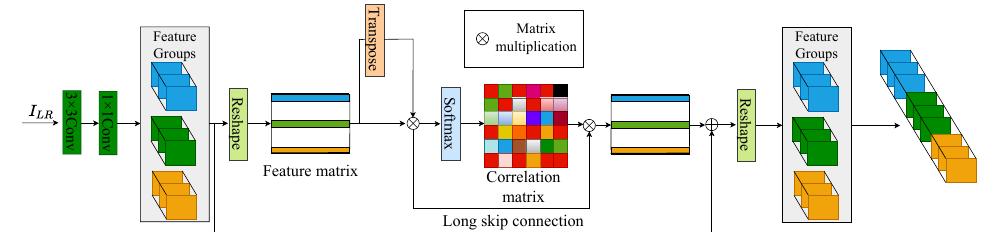
Figure 2. Architecture of the proposed LAFE module.